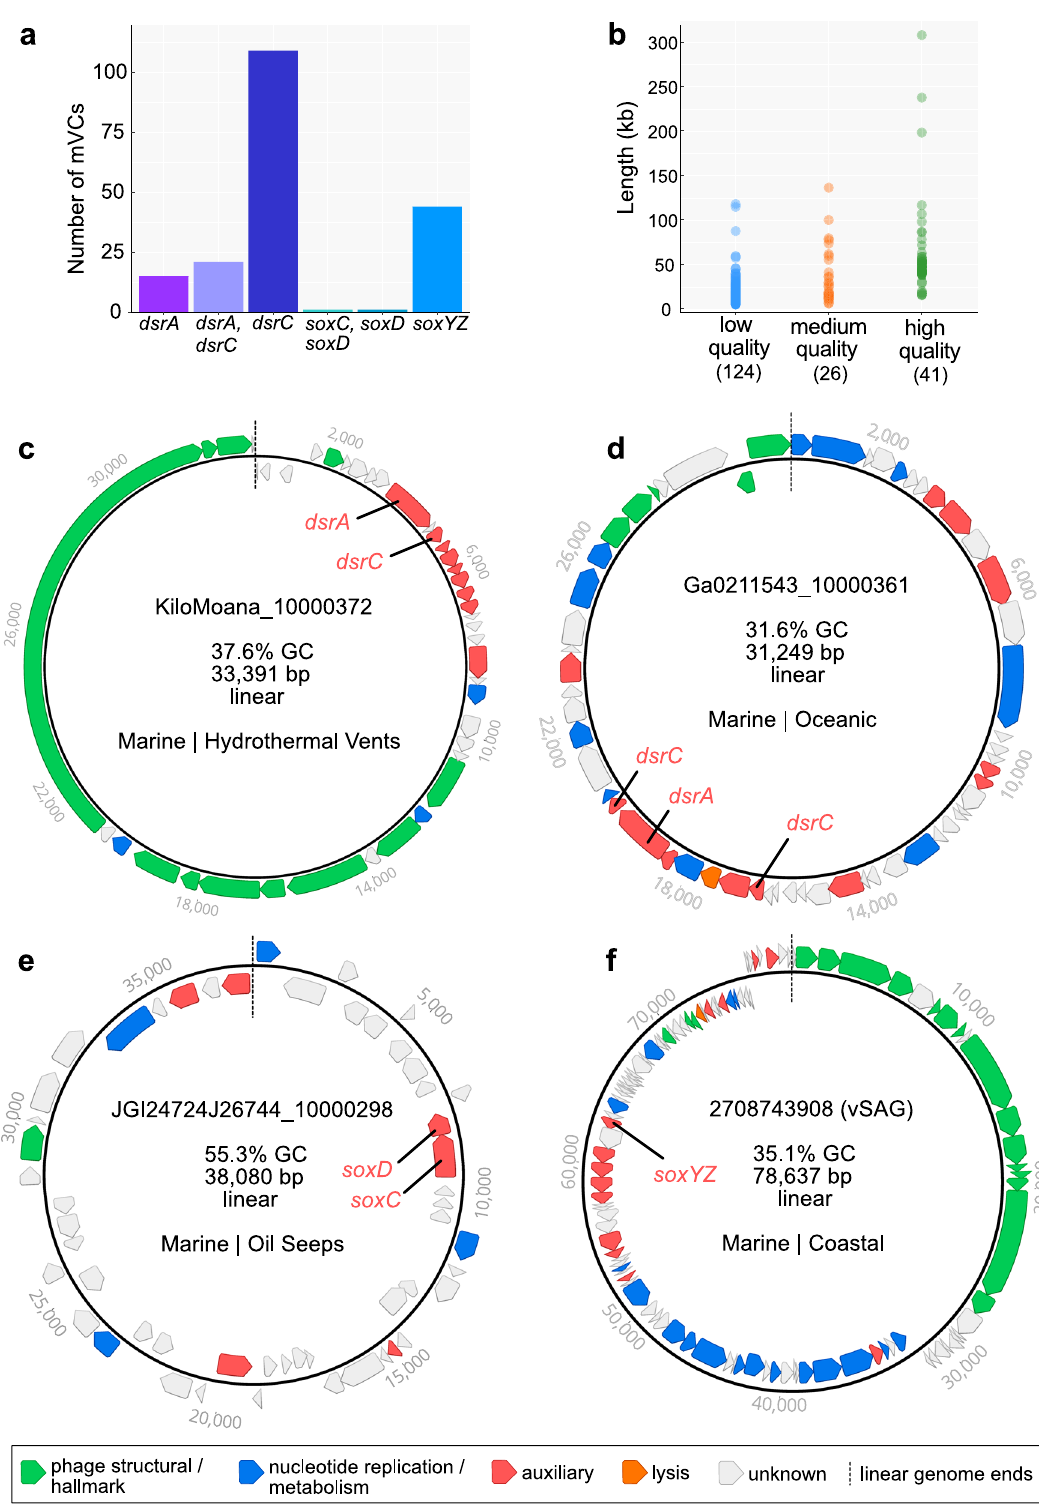
Fig. 1 Dataset summary statistics and representative genome organization diagrams of mVCs. a The number of mVCs, 191 total, encoding single or multiple DSM AMGs. b Estimated mVC genome qualities as a function of scaffold lengths. mVCs encoding c dsrA and dsrC , d dsrA and two dsrC , e soxC and soxD , and f soxYZ . For c , d , e , and f linear mVC scaffolds are visualized as circular with the endpoints indicated by dashed lines, and predicted open reading frames are colored according to VIBRANT annotation functions. vSAG: viral single-ampli fi ed genome, GC: guanine-cytosine content, bp: base